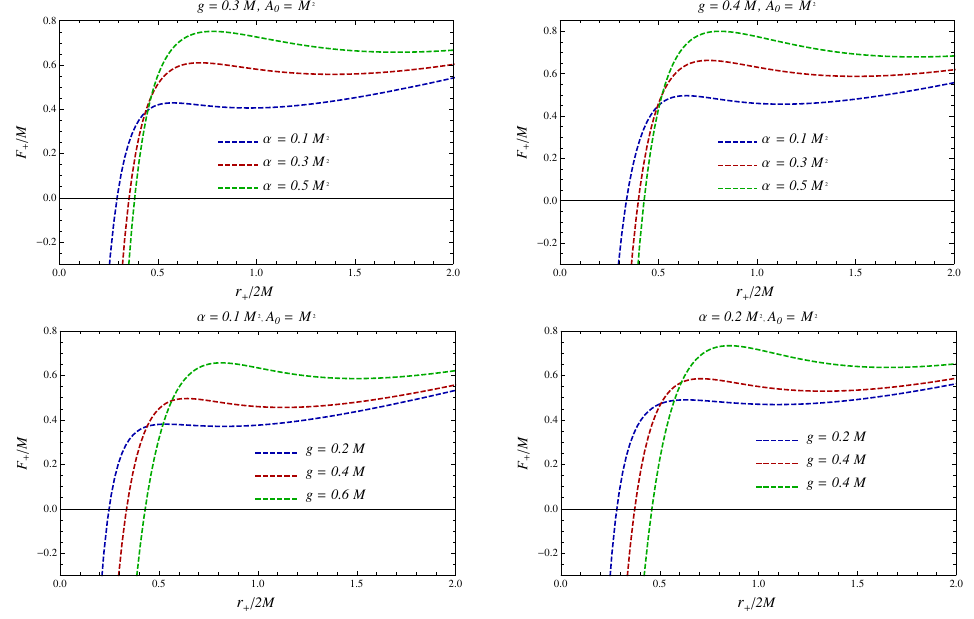
Figure 4. 4 D nonsingular EGB black holes Gibb’s free energy F + vs. horizon r + for various values of α and g